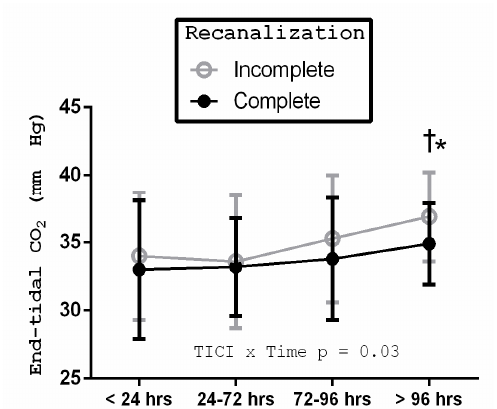
Figure 3. End-tidal CO 2 trends with time. The end-tidal CO 2 was decreased in the < 24 h compared to the late time point of the study (time p < 0.01). After 96 h, incomplete recanalization was significantly associated with a higher end-tidal CO 2 (* p < 0.01). The mean and SD values allowed for discrimination.